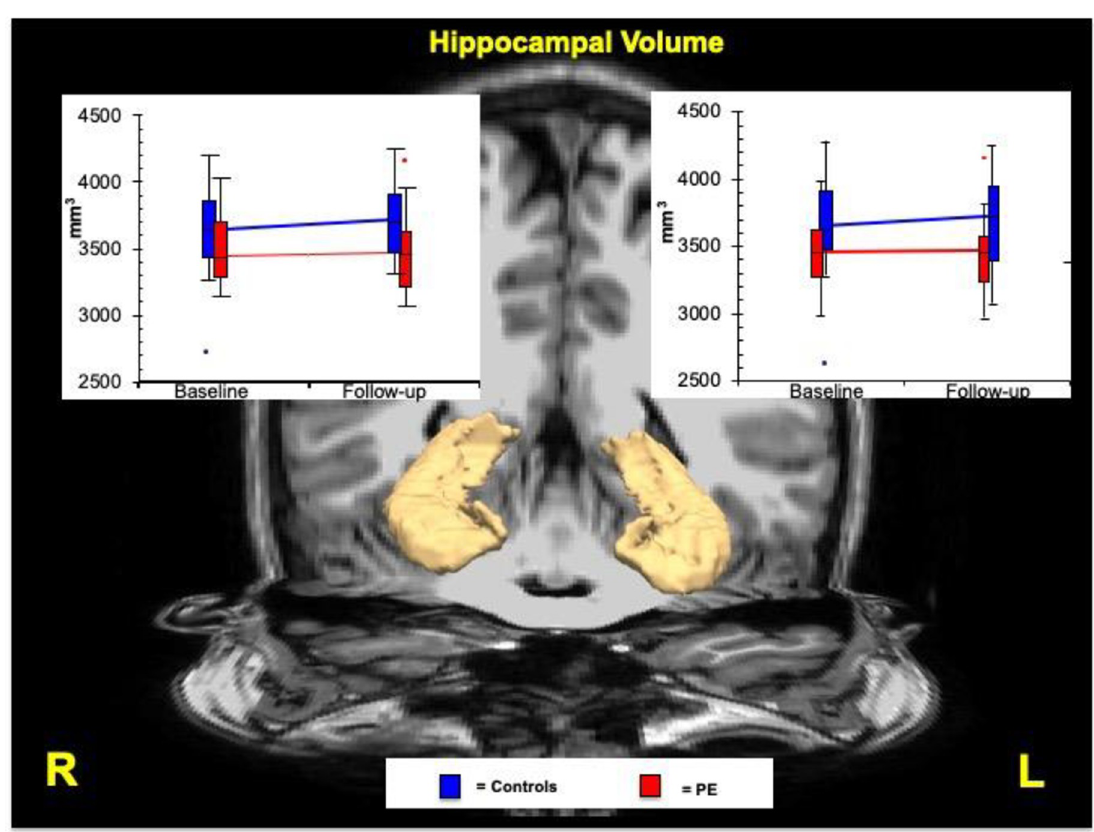
Fig 1. Patterns of change of hippocampal volume over 2 years follow-up between the PE and control group. Graphs show volumetric measures at baseline and follow-up in left and right whole hippocampus. Trendlines provide rates of volume change during the two time points between the PE and control group. Blue represents the control group and red represents the PE group. Outliers are shown as dots in both graphs. Volumes are shown in millimeters cubed. PE, adolescents reporting psychotic experiences.